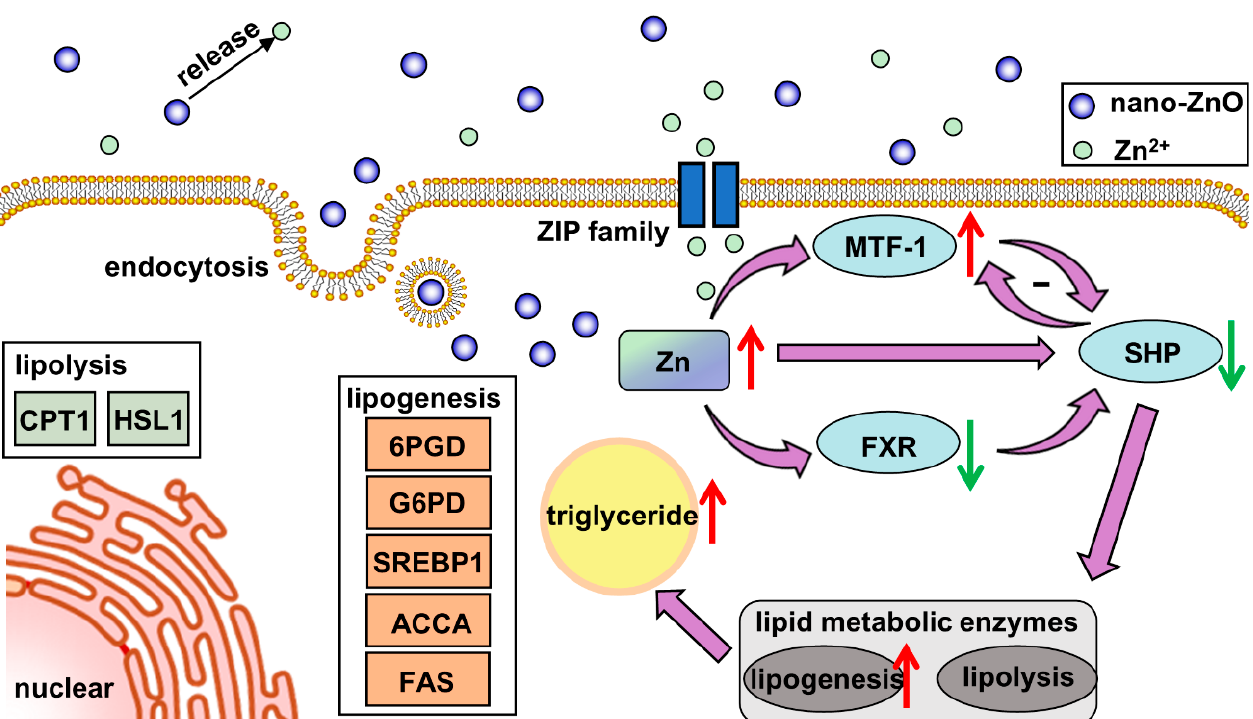
Figure 8. Model diagram of the nano-sized ZnO absorption and its effects on lipid metabolism in yellow catfish.